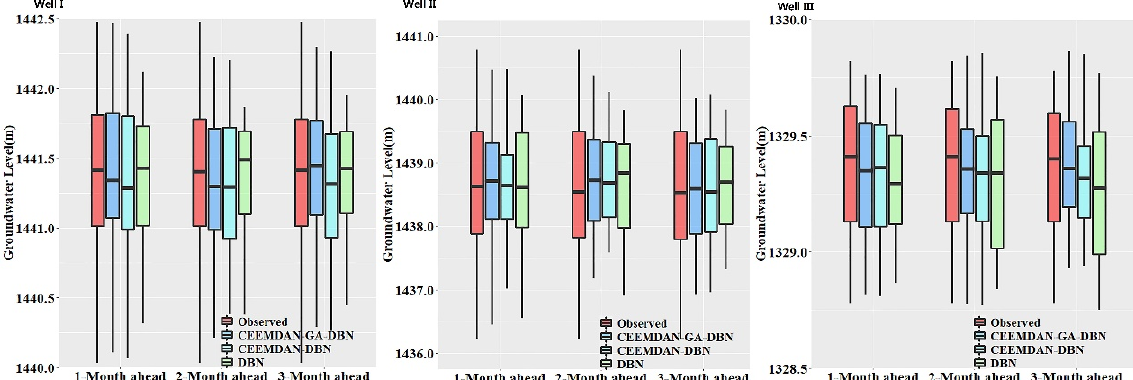
Figure 10. Boxplots of the distribution for the observed and simulated groundwater level forecast for the 1-, 2- and 3-month ahead groundwater level generated by the CEEMDAN-GA-DBN, CEEMDAN-DBN and DBN models in the testing period.